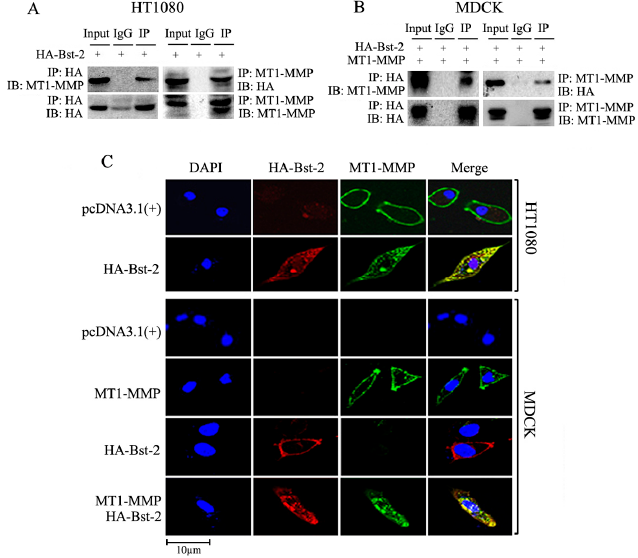
Figure 3. MT1-MMP interacted and co-localized with Bst-2 in HT1080 and MDCK cells. ( A , B ) Cells were cultured in 10-cm dishes and transfected with HA-Bst-2 (HT1080 cells) and co-transfected HA-Bst-2 with MT1-MMP (MDCK cells) as indicated in figures; 48 h after transfection, cells were harvested and lysed for co-immunoprecipitation with MT1-MMP antibody or HA-tag antibody, respectively; then HA-Bst-2 or MT1-MMP was checked with related antibodies as described in figures in co-immunoprecipitated protein complexes; ( C ) HT1080 and MDCK cells were seeded and grown on glass coverslips in 6-well plates overnight; then transfected with HA-Bst-2 alone in HT1080 cells, and co-transfected with MT1-MMP and HA-Bst-2 in MDCK cells. After being cultured with GM6001 (5 mM) for 48 h, cells were treated for Immunostaining Confocal Microscopy assay with related antibodies. IP: Immunoprecipitation; IB: Immunoblotting; WB: Western